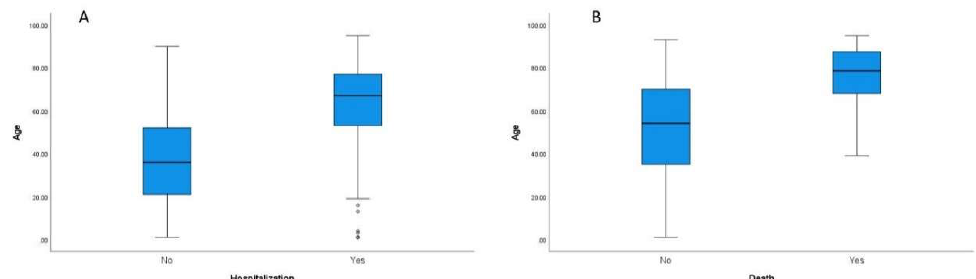
Figure 2. Association between age and clinical outcomes. ( A ) Association among the age of the participants and the need for hospitalization. Participants that needed hospitalization were older (mean age 63.9 vs. mean age 34.5). ( B ) Association among the age of the participants and death. Participants that died were older (mean age 76.5 vs. mean age 51.1).